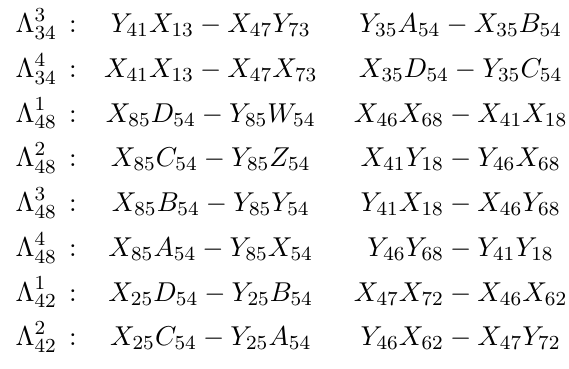
Figure 31 . Quiver diagram for phase L of Q 1 , 1 , 1 / Z 2